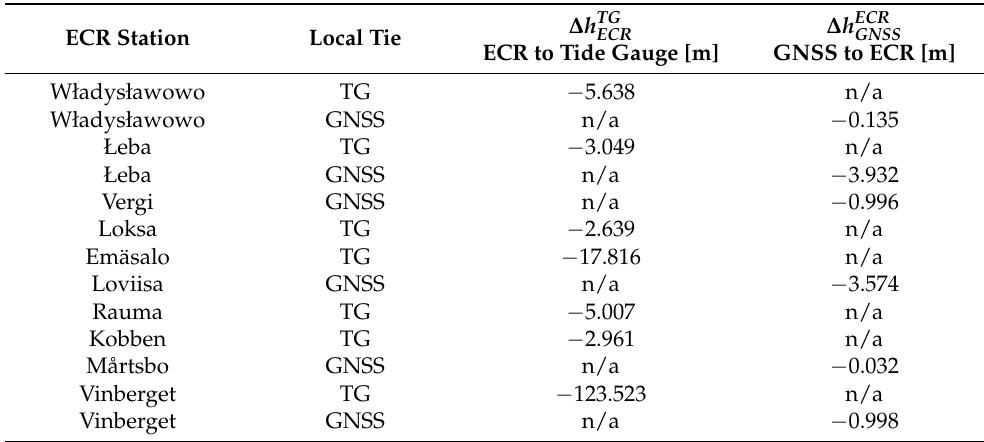
Table 10. Levelled height differences between ECR reference point and the TG or GNSS reference points. ∆ h TG : ellipsoidal height difference from ECR reference point to TG zero marker; ∆ h ECR ECR ellipsoidal height difference from GNSS reference point to ECR reference